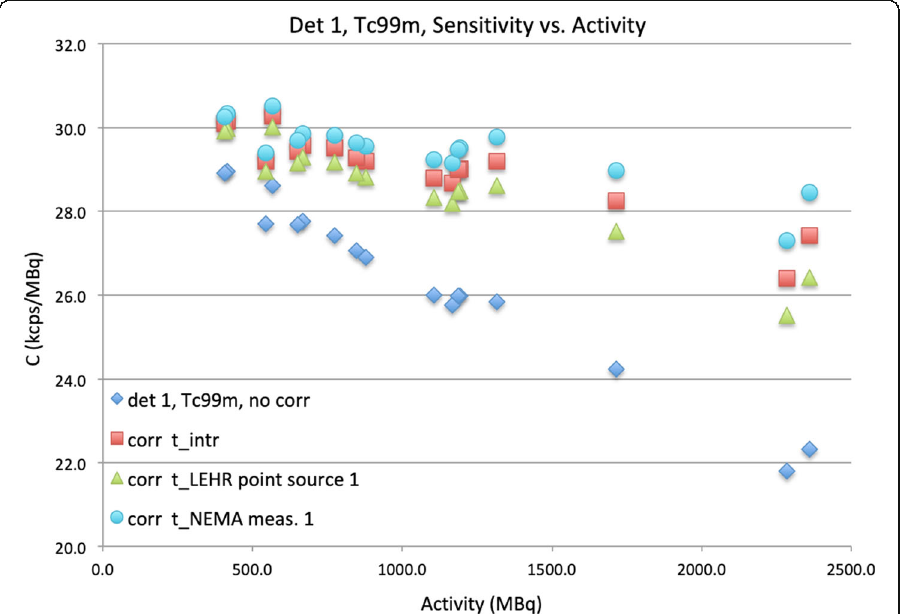
Fig. 8 Dead time corrections for the 99m Tc window measurement of the phantom. Sensitivity ( C Tc ) in kcps/ MBq vs. A (MBq) for the second extrinsic phantom measurement, detector 1, 99m Tc energy window. Dead time values τ Tc (i.e., from photopeak windows) from different measurements were used for correction: blue diamonds, uncorrected; red squares, τ Tc measured in the intrinsic point source measurements (from Table 2); green triangles, τ Tc from the first extrinsic point sources measurements (Table 4); and cyan circles, τ Tc from the first scatter phantom measurement (also Table